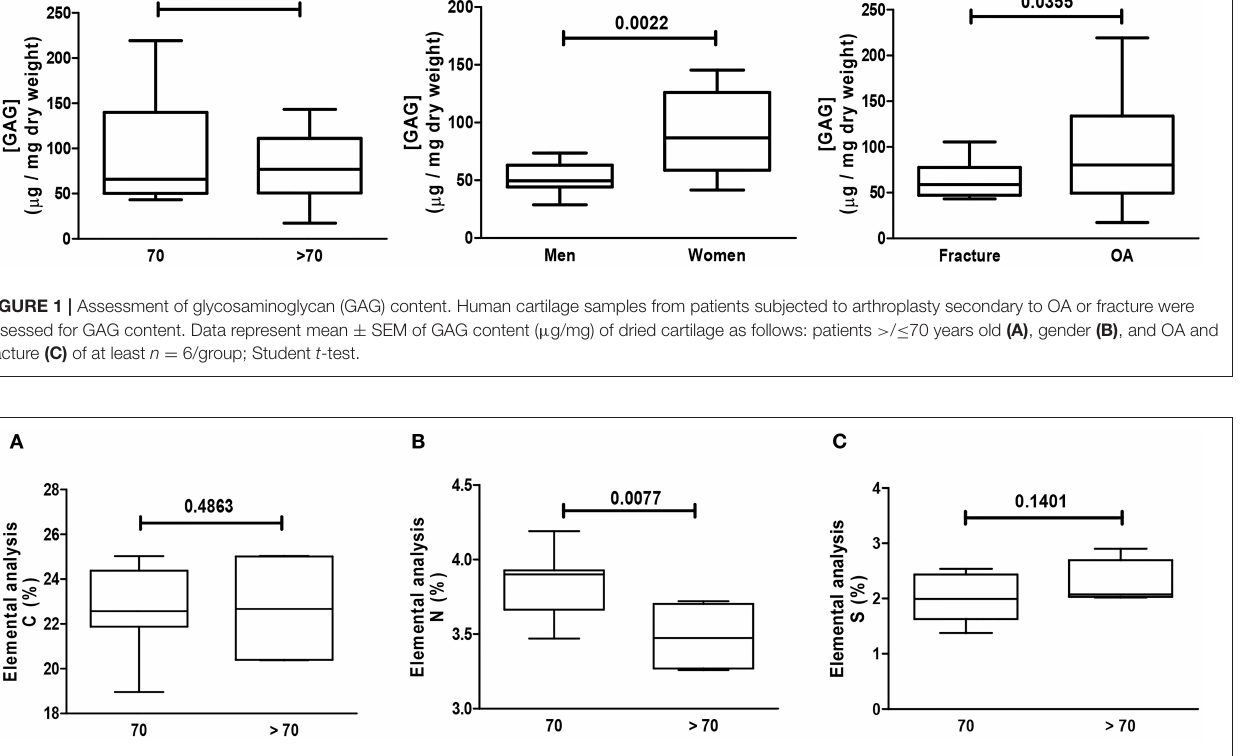
FIGURE 2 | Elemental analysis of GAG. Elemental analysis of GAG from human cartilage samples of patients > / ≤ 70 years old subjected to arthroplasty secondary to OA or fracture. Data represent medians (IQR) of relative percentage of carbon (C), nitrogen (N), hydrogen (H), and sulfate (S) of at least n = 6/group; Kruskal–Wallis test.